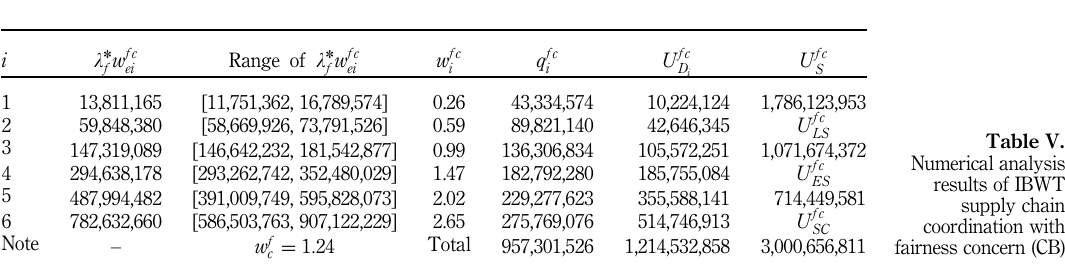
Table IV. Numerical analysis results of IBWT Supply chain coordination with fairness concern